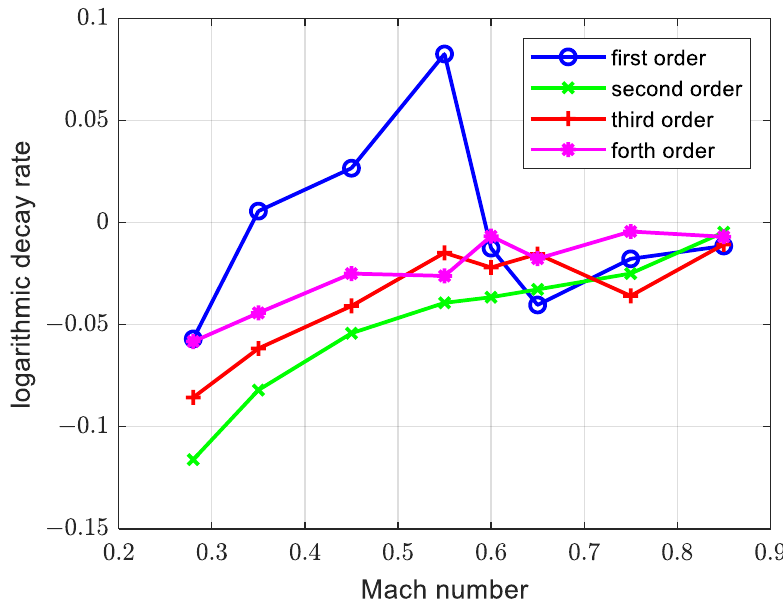
Figure 18. Variations in the logarithmic decay rate of generalized displacement with the Mach number ( p = 800 Pa, α = 45 ◦ ).